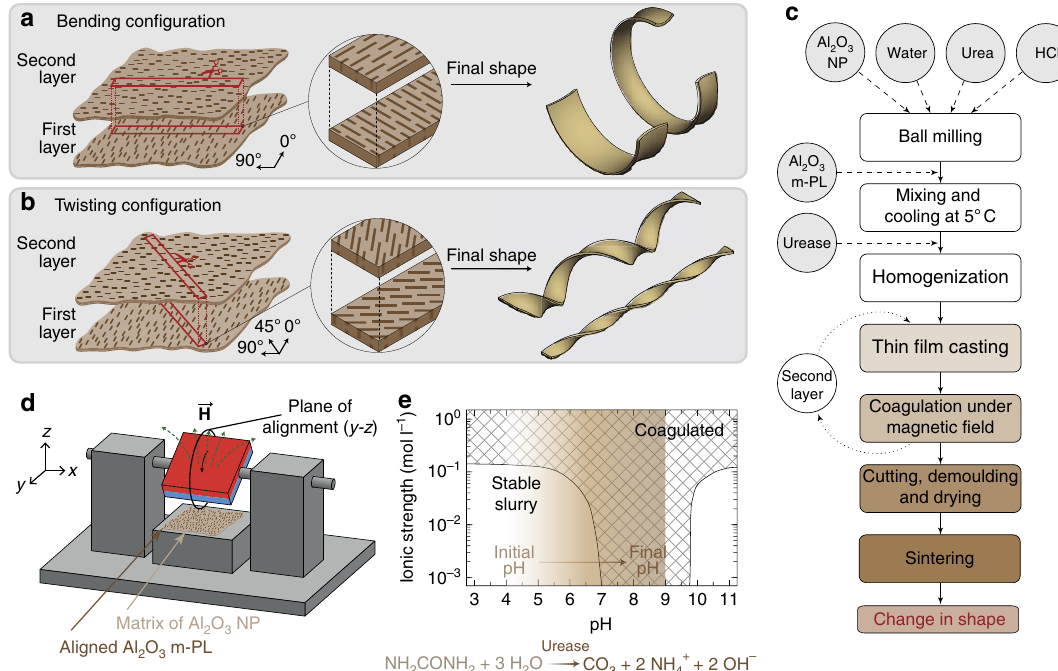
Figure 1 | Design and processing of microstructured bilayers programmed to self-shape during sintering. Bilayer samples containing platelets orthogonally aligned in each layer can result in ( a ) bending or ( b ) twisting, depending on the microstructure within the strip. ( c ) Flowchart of the procedure developed to prepare programmable self-shaping ceramics. ( d ) Schematic representation of the setup used for platelet alignment. Biaxial alignment occurs along the plane in which the magnetic field is rotating, which corresponds to the ( y – z ) plane in our coordinates. ( e ) Colloidal stability diagram showing the pH change induced through the catalysed decomposition of urea by the enzyme urease, which was used to fix the microstructure in each layer after magnetic alignment. This graph was plotted using data from Gauckler et al.